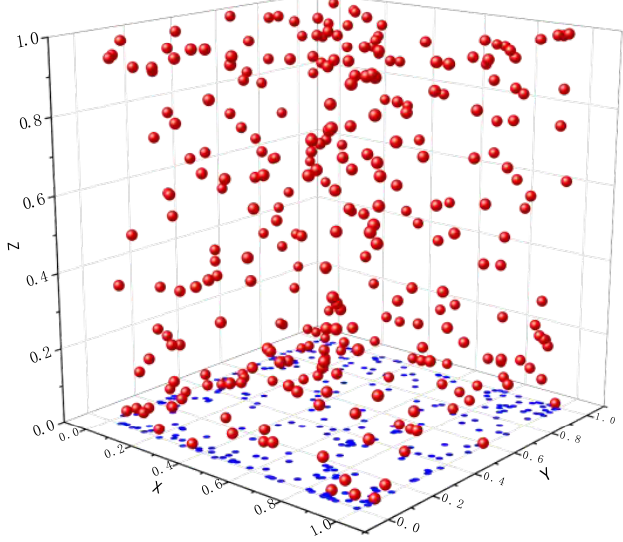
Figure 3. Spatial distribution of logistics chaotic mappings.